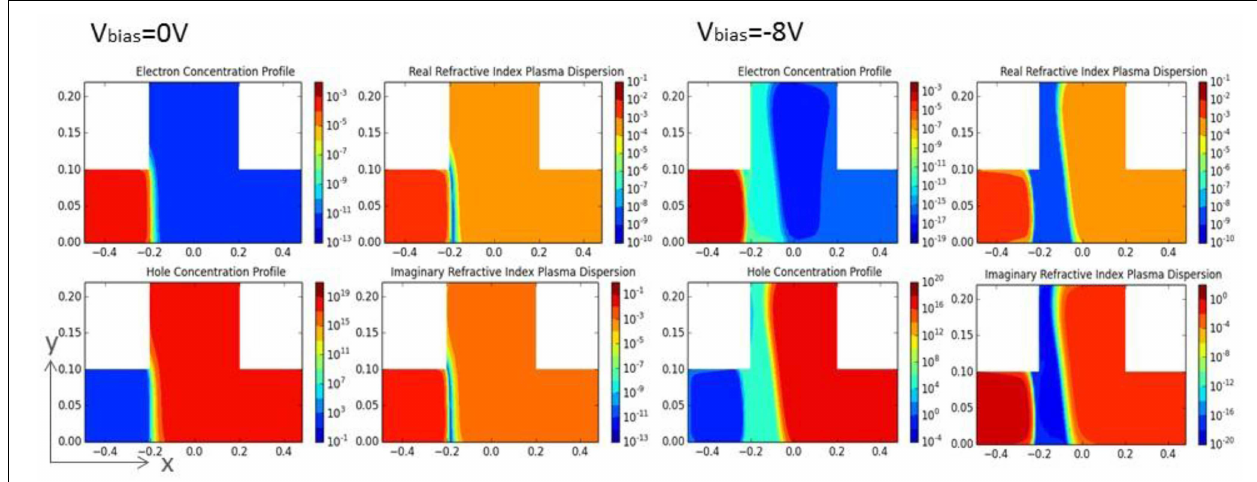
FIGURE 2 | Contour plots of non-uniform carrier concentration and it equivalent complex refractive indices for mod1 at 0V and − 8V.